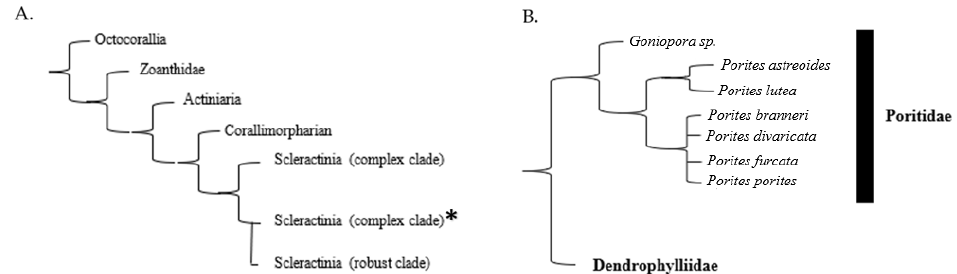
Figure 1. ( A ) Generalized taxonomic summary of the coral subclass Hexacorallia. Clade location of Poritidae is indicated with asterisks ( B ) A generalized phylogenetic tree, based on species with available mitochondrial sequence data. Porites astreoides is found within Poritidae (indicated with a black bar). Adapted from Kitahara et al. 2010 [17].